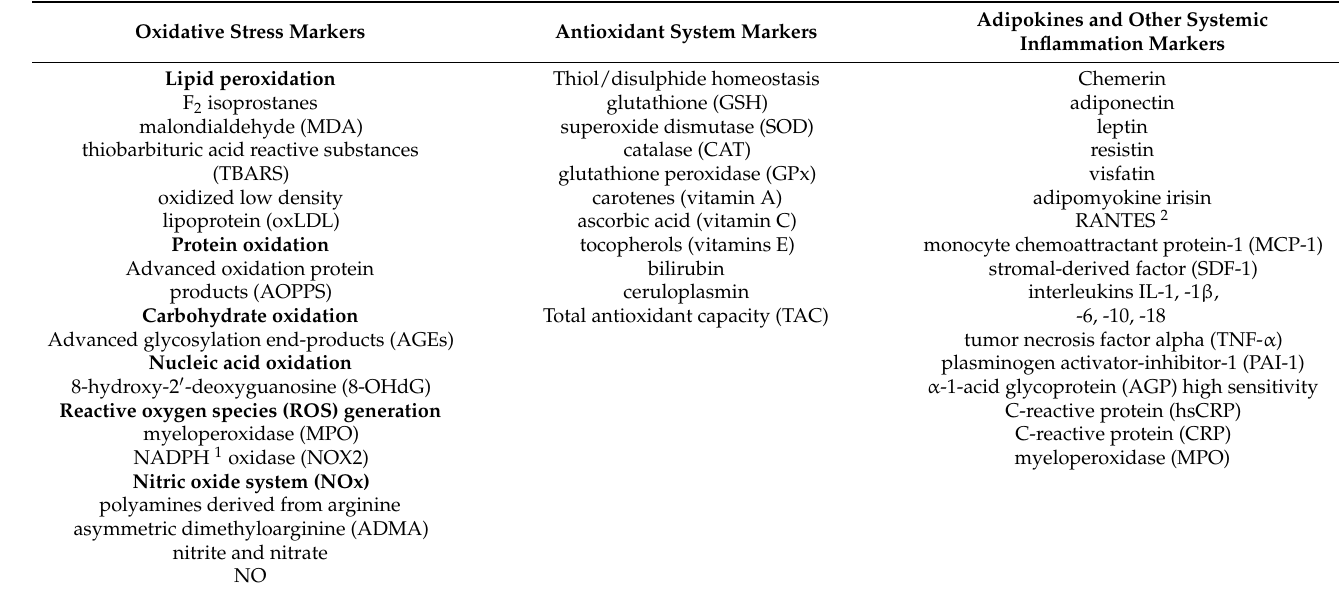
Table 3. Oxidative and inflammatory markers associated with cardiovascular